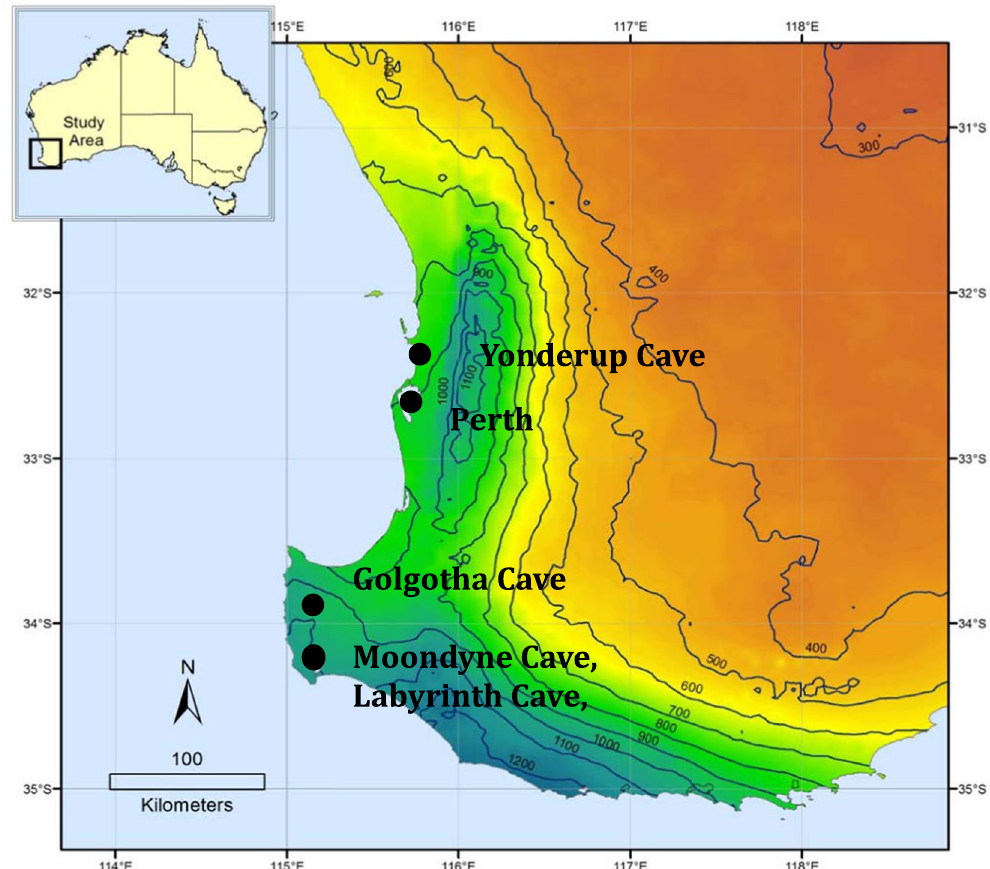
Figure 1. Geographic location of cave sites Yonderup Cave, Labyrinth, Moondyne Cave, and Golgotha Cave relative to Perth, and the regional rainfall isohyets in mm, with the mediterranean climate zone being between the coast line and the 600 mm isohyet line. Figure composed using ESRI ArcGIS v10.2 software (http://www. esri.com/software/arcgis/arcgis-for-desktop), and data based on Bureau of Meterology 30 and Geoscience Australia material © Commonwealth of Australia (Geoscience Australia)